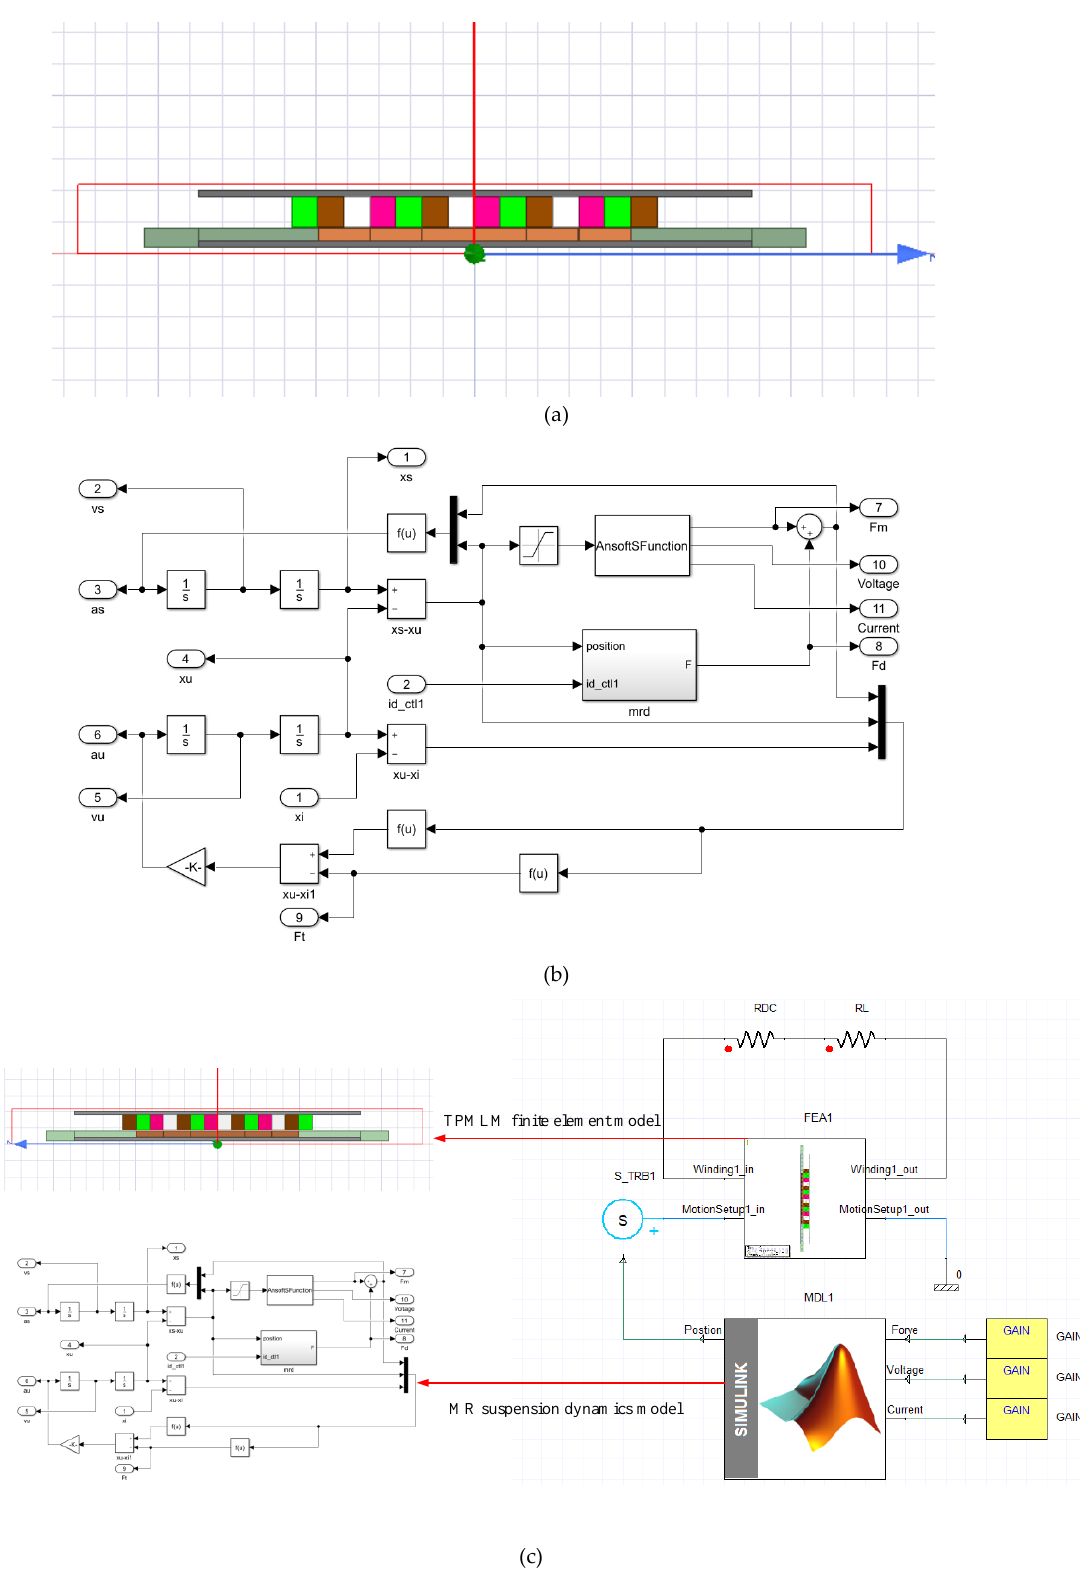
Figure 3. Schematic diagram of the MR regenerative suspension system simulation platform. ( a ) A finite element simulation model, ( b ) Suspension dynamics simulation model, ( c ) Joint simulation